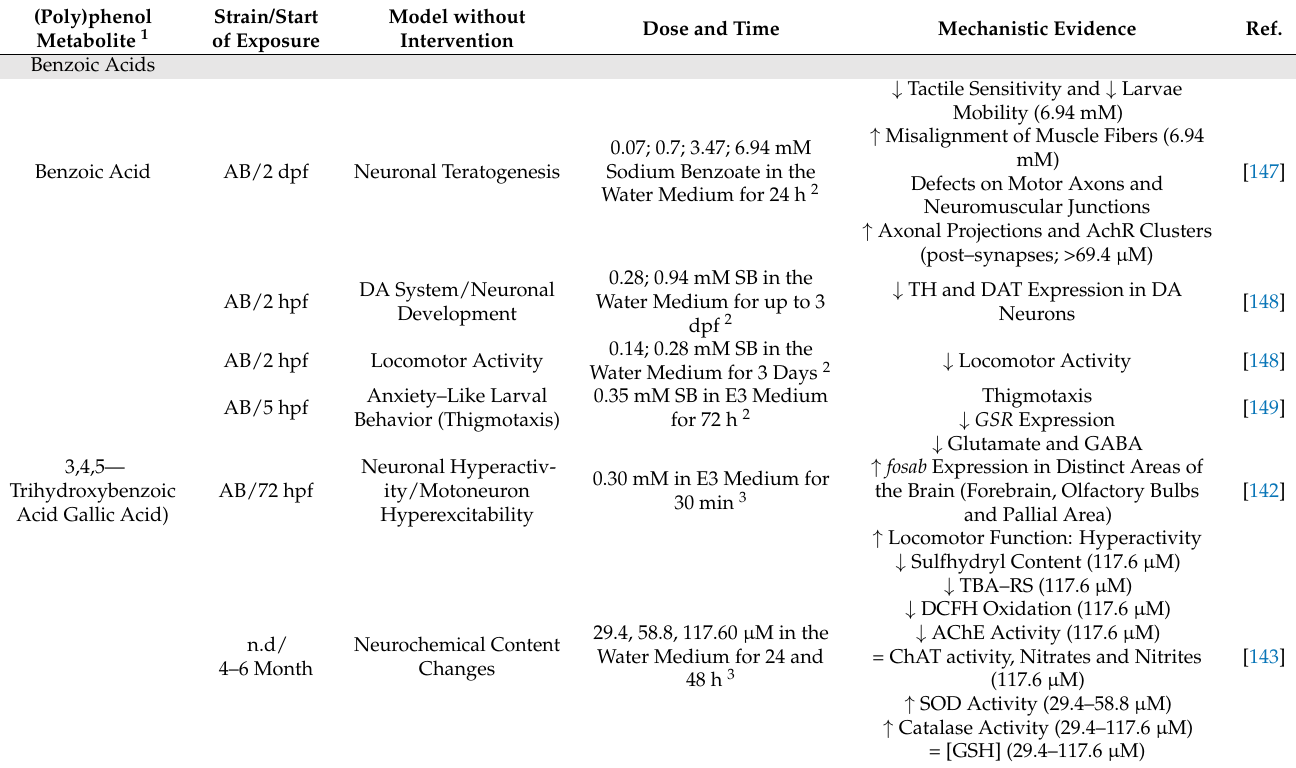
Table 5. Effects of low molecular weight (poly)phenol metabolites in zebrafish neurophysiological functions.